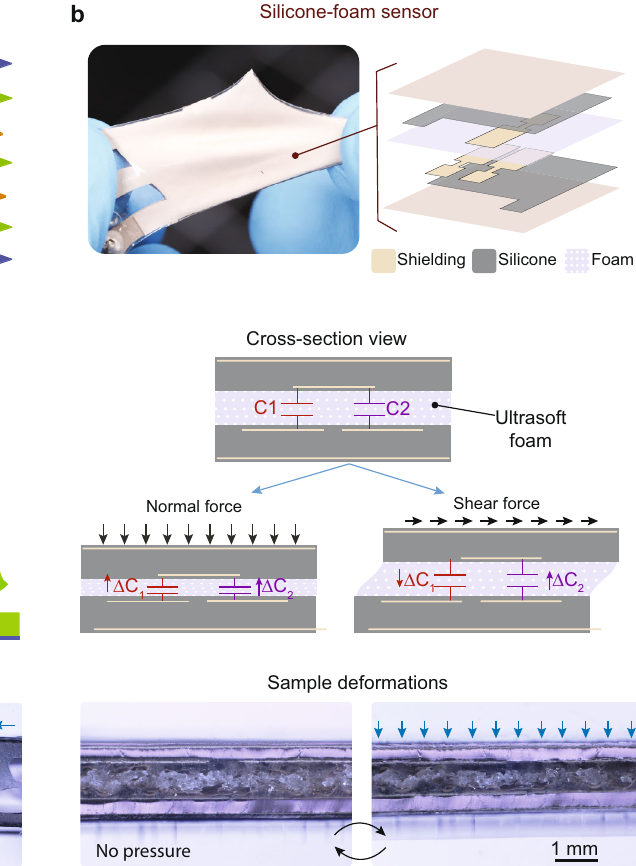
the silicone-foam-based sensor. An ultrasoft foam is used asthe dielectric material between the sensing electrodes. Similar to the LM design, the foam deforms easily under both shear and normal forces, allowing very sensitive force measurements.